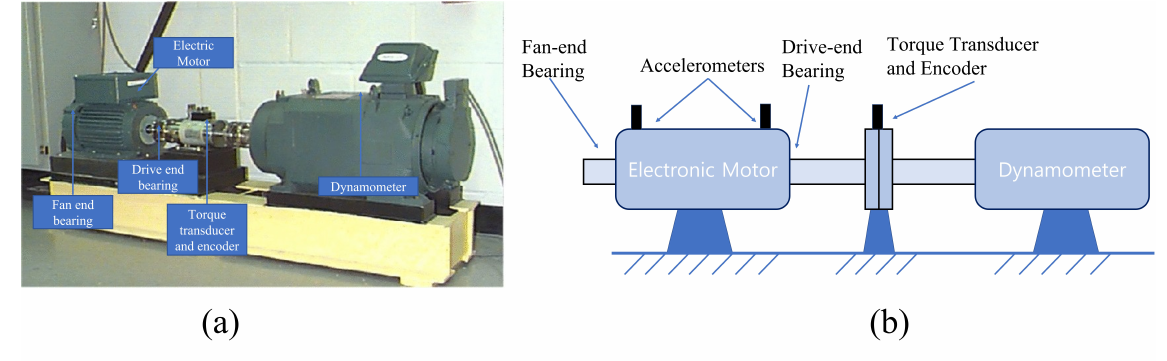
Figure 6. ( a ) The bearing simulator of CWRU and ( b ) its cross-section